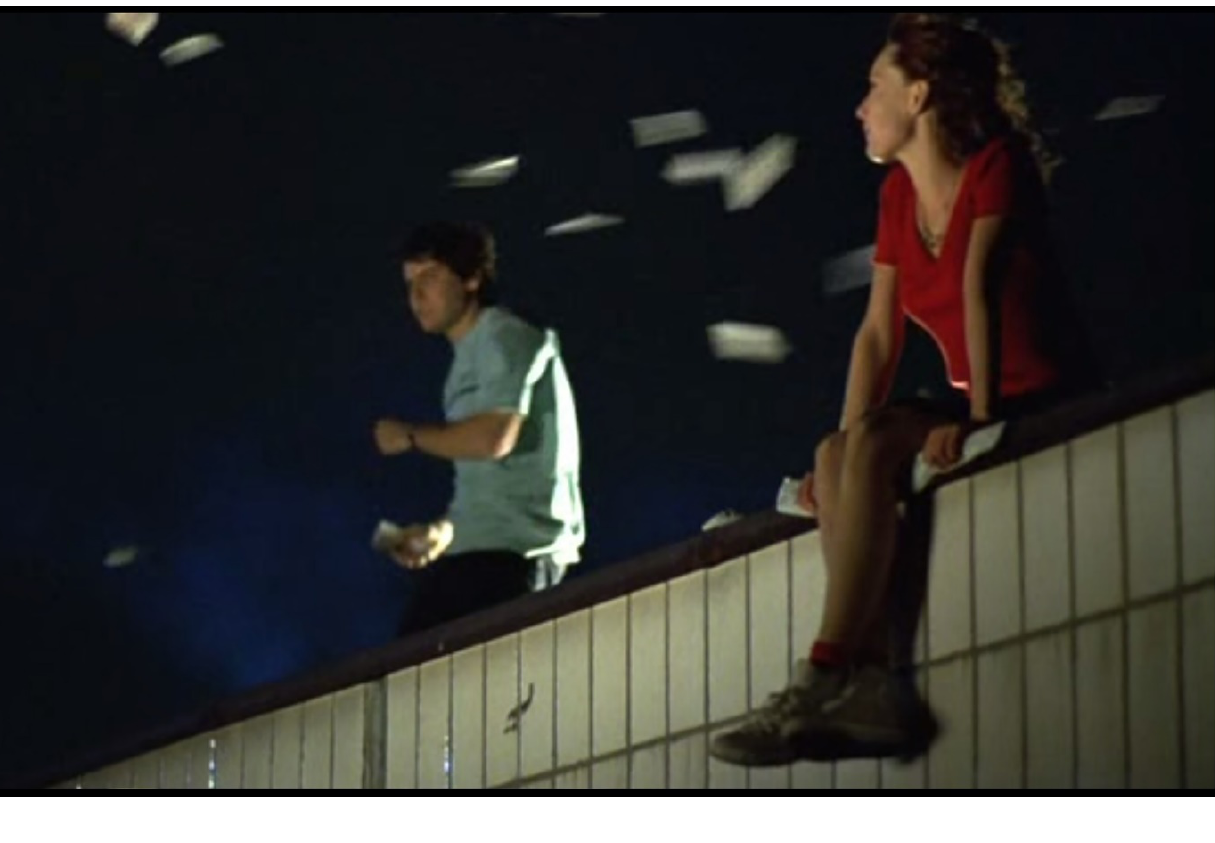
Figure 1 Alex throws the old money about.